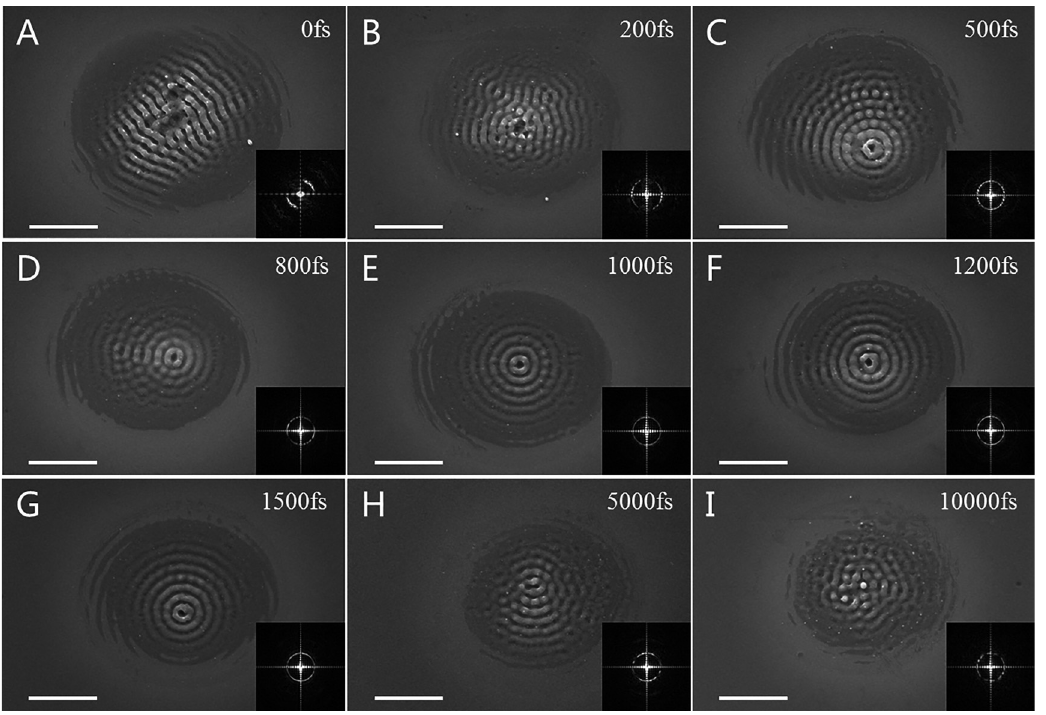
Figure 3: Formationof nanometric concentricring structuresonsilicon surfaceswhenthe burstnumber was fixed at 4 andthe timedelay was 0fsto10ps.TherelevanttwodimensionalfastFouriertransform(2D-FFT)imageisillustratedinthebottomrightofeachSEMimage.Thescale bar represents 5 μ m.